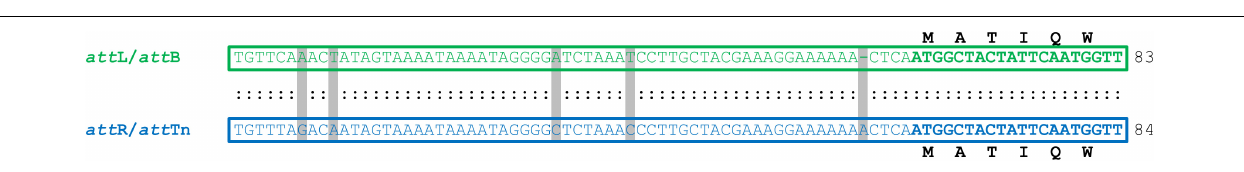
FIGURE 2 | Sequence alignment of Tn 5253 attachment sites in Streptococcus pneumoniae D39 and derivatives. Upon integration into pneumococcal chromosome, Tn 5253 is flanked by att L and att R. The element excises from chromosome producing a circular form where the left and right ends are joined by att Tn and restoring the att B insertion site. att B is 83-bp long and is identical to att L while att Tn is 84-bp long and is identical to att R. att R- att Tn contain 4 nucleotide changes and 1 insertion compared to att L- att B. att L- att B contains the first 20 nucleotides of rbgA CDS, whose deduced amino acid sequence is reported, together with the 63 nucleotides upstream of the start codon. Within the sequences, identical nucleotides are indicated by colon, changes are shaded. Amino acids are indicated using one-letter code abbreviations. Lengths of attachment sites are reported on the